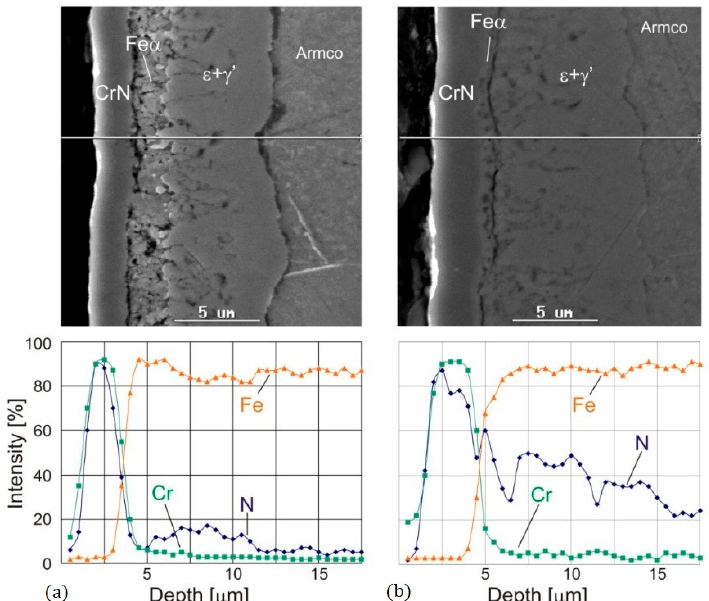
Figure 5. The results of a linear analysis of the chemical composition for the nitrided layer with a layer of iron nitrides on the surface, after ion etching and the deposition of the CrN coating: ( a ) etching in the Cr + plasma, ( b ) etching in the Cr + + N + plasma. Reprinted from permission from [15]. Copyright 2007 the Łukasiewicz Research Network—Institute for Sustainable Technology.